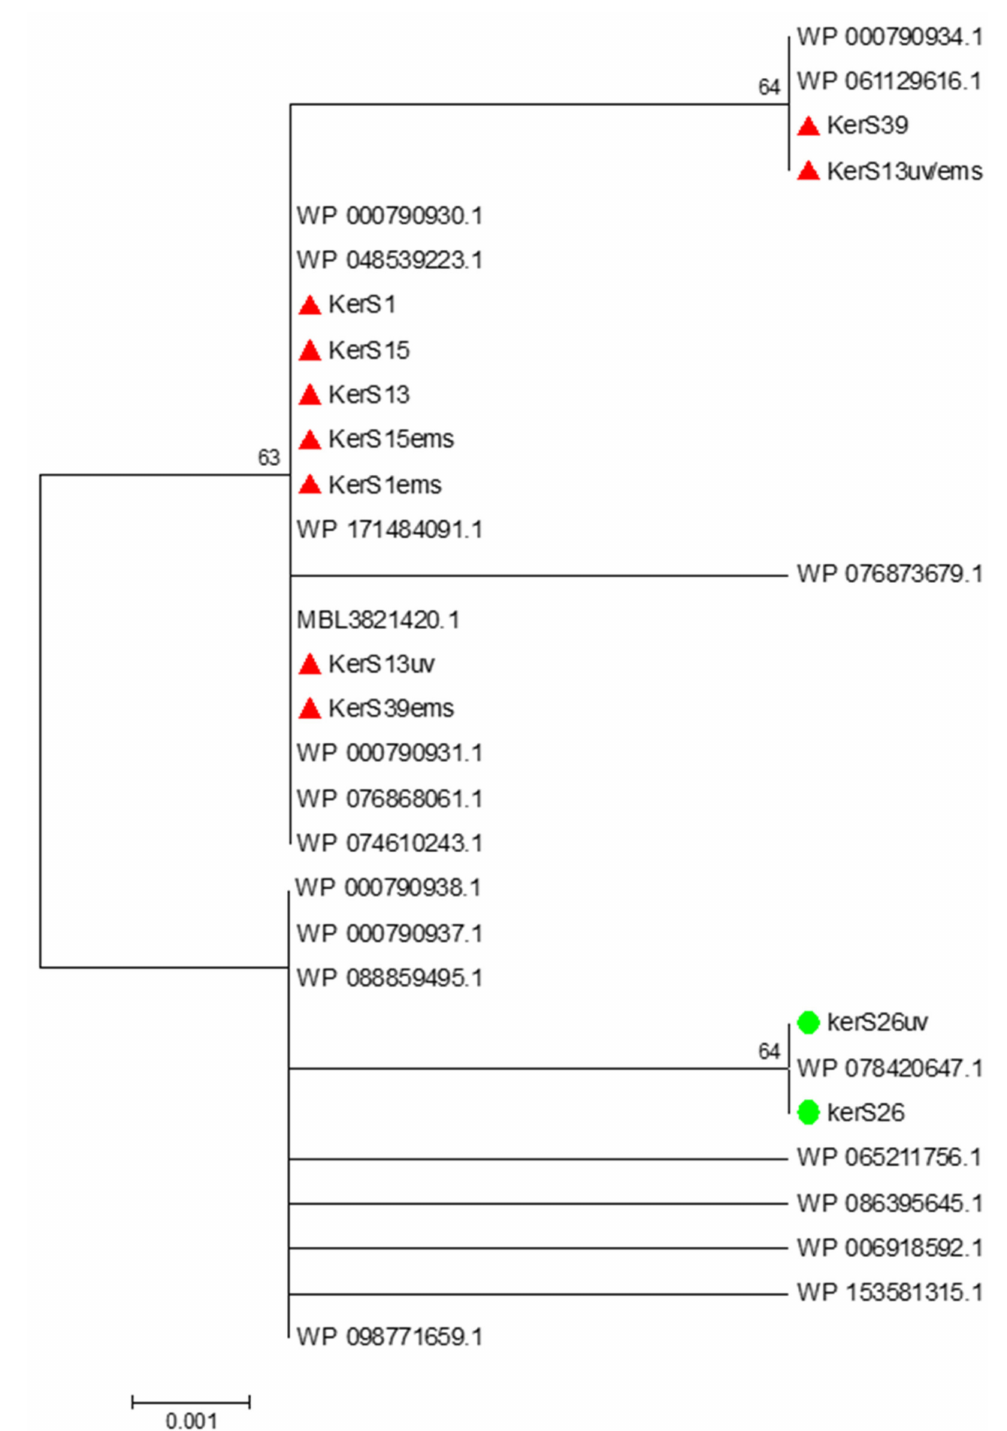
Figure 9. Neighbor-joining phylogenetic analysis of KerS gene against S8 family peptidase Bacillus cereus group sequences retrieved from GenBank